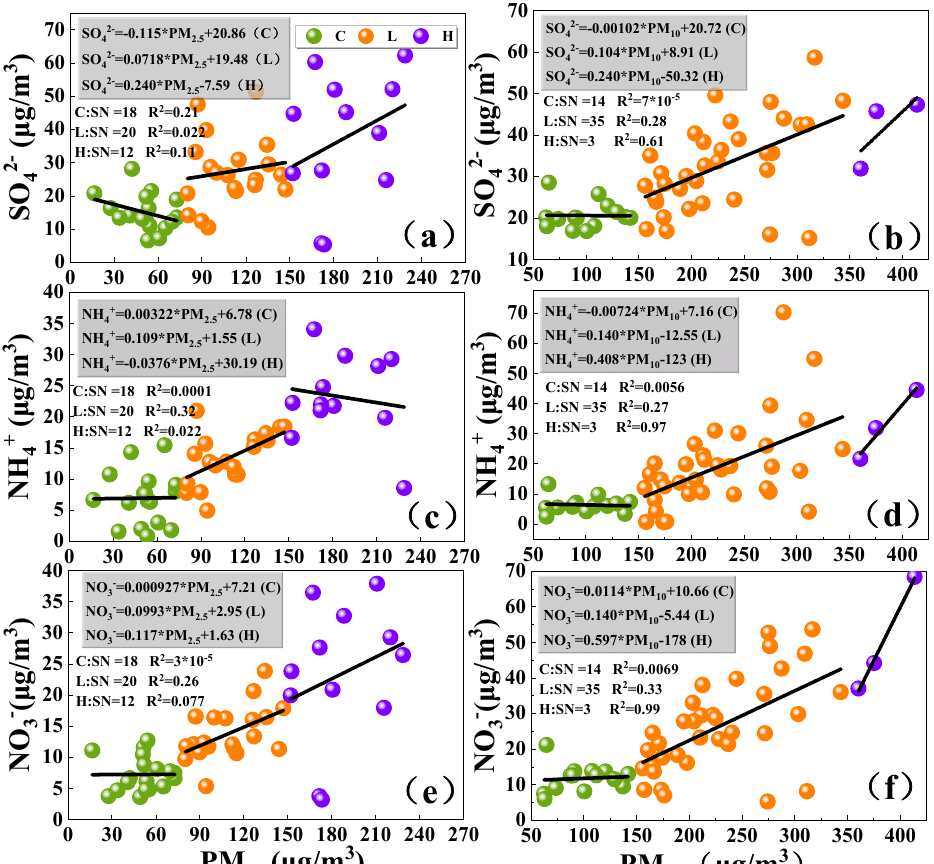
Figure 7. Linear regression of SO 4 2 − with ( a ) PM 2.5 and ( b ) PM 10 , NH 4 + with ( c ) PM 2.5 and ( d ) PM 10 , NO 3 − with ( e ) PM 2.5 and ( f ) PM 10 at different pollution levels ( p < 0.05; C: Clean; L: Light-Medium; H: Heavy; SN means sample number).